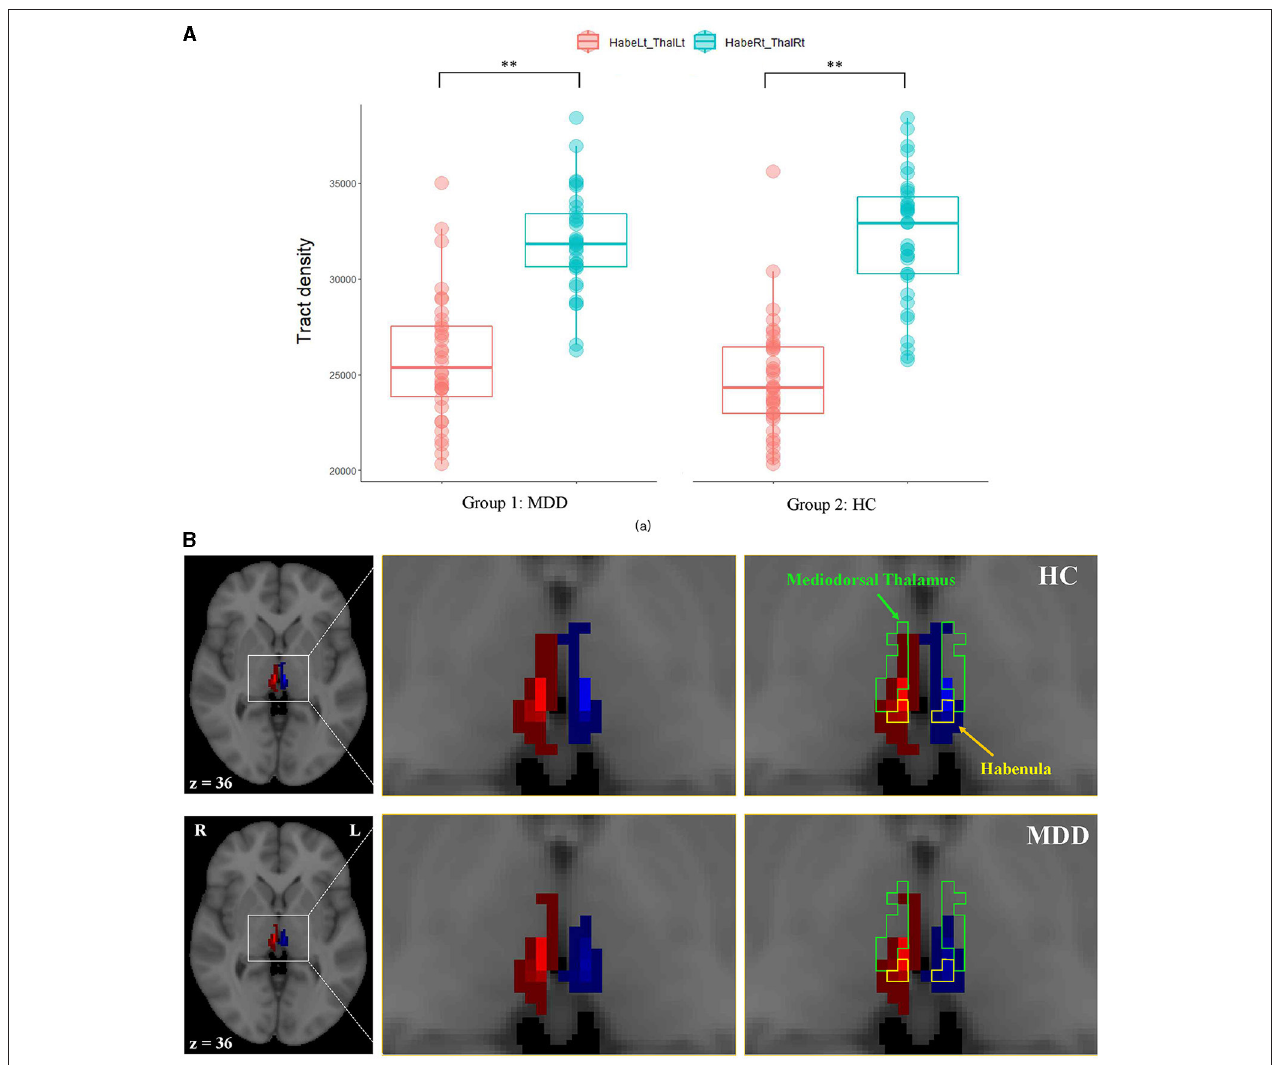
FIGURE 3 | The comparison of ipsilateral tracts from the mediodorsal thalamus to the habenula between hemispheres. (A) Box plots of the tract densities between hemispheres in the MDD and NC groups, (B) a representative ipsilateral fiber connection in an MDD (bottom) and an NC (top) participant. Fiber connections between the right habenula and the right thalamus are shown in red, and fiber connections between the left habenula and the left thalamus are shown in blue. The green and yellow boundaries represent regions of the mediodorsal thalamus and the habenula, respectively. Lt, left; MDD, major depressive disorder; NC, normal control; Rt, right. **Indicates statistical significance ( p <